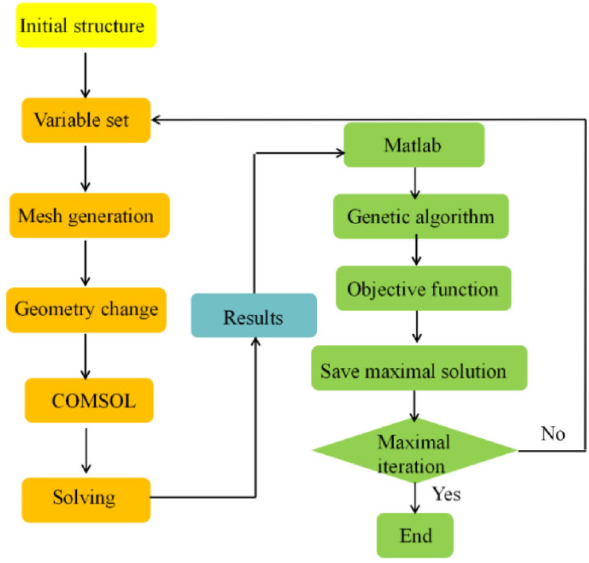
Figure 2. Flow chart of the co-simulation of COMSOL and GA used in this